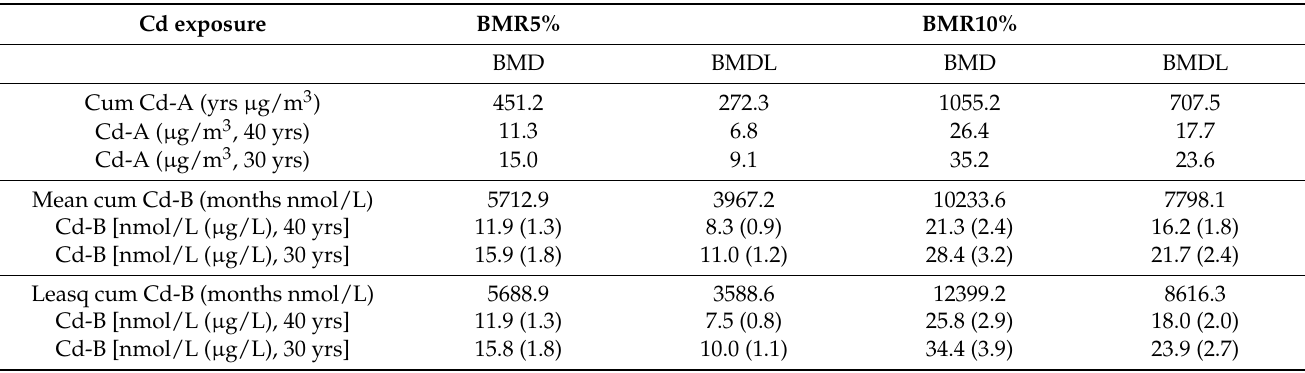
Table 3. Benchmark doses of cumulative cadmium exposure and cadmium concentrations corresponding to the entire working period of 40 or 30